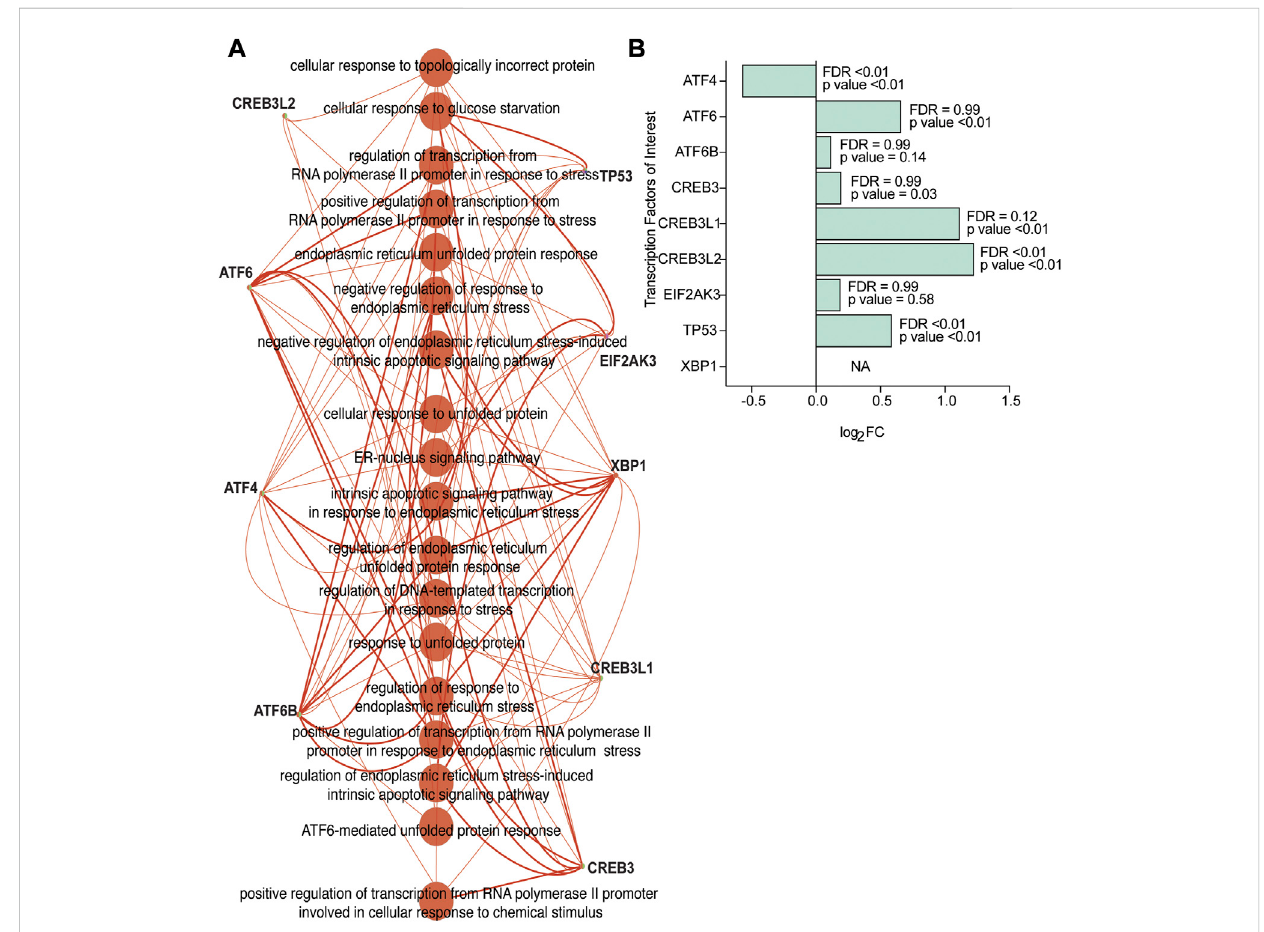
Transcriptional regulators from the human Affymetrix dataset con fi rmed as linked to ER stress and UPR-related processes. (A) The transcriptional regulators CREB3L2,ATF6,ATF4,ATF6B,TP53,EIF2AK3,XBP1,CREB3L1,andCREB3correspondtoER-stressandUPR-related enrichedprocesses based on gene ontology analysis on all the identi fi ed transcription factors, and orthologues (NES > 3.00) identi fi ed using iRegulon. (B) Gene expression levels of the transcription factors of interest (based on a higher NES value and ontology analysis on transcription factors) subsetted from the